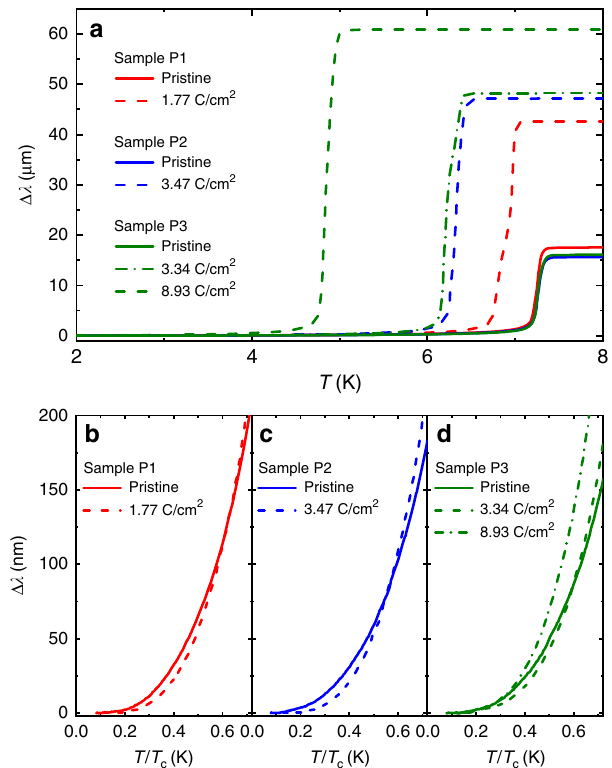
Fig. 4 Temperature dependence of London penetration depth Δ λ upon electron irradiation. Results of three samples before and after irradiation: P1 (0 and 1.77 C cm − 2 ), P2 (0 and 3.47 C cm − 2 ), and P3 (0, 3.34, and 8.93 C cm − 2 ). a Wide temperature span of Δ λ that shows a substantial decrease of T c upon irradiation. b – d The low-temperature part of Δ λ of b P1, c P2, and d P3 samples before and after irradition. All data clearly show the saturating behaviour below 0.2 T / T c , supporting the presence of s -wave